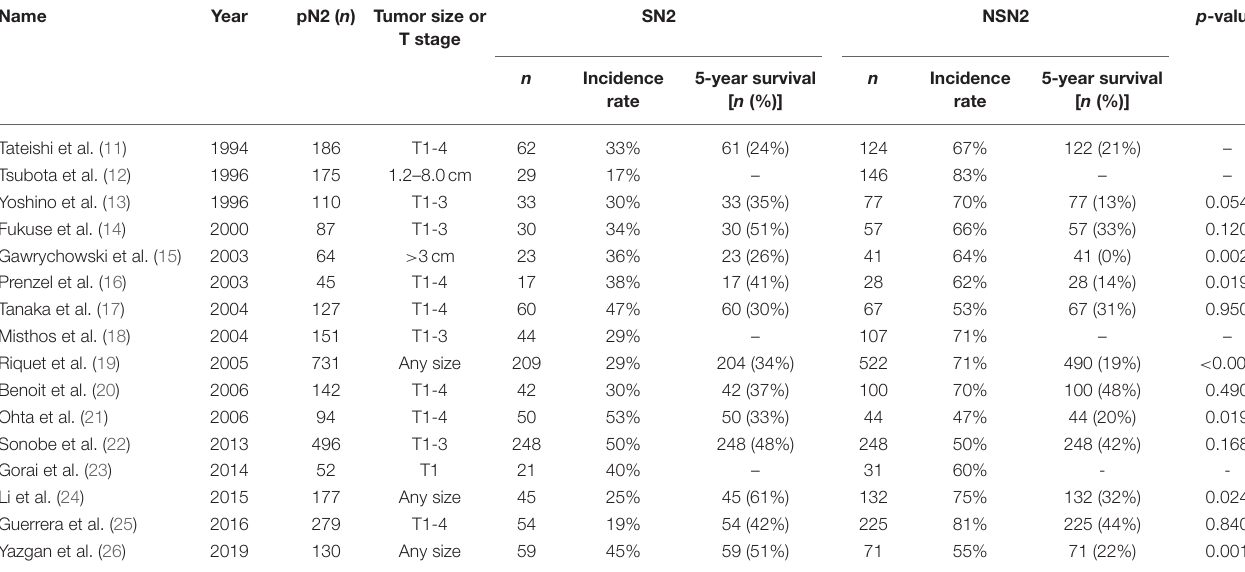
TABLE 1 | The studies of mediastinal lymph node metastasis involving skip N2 and non-skip N2.